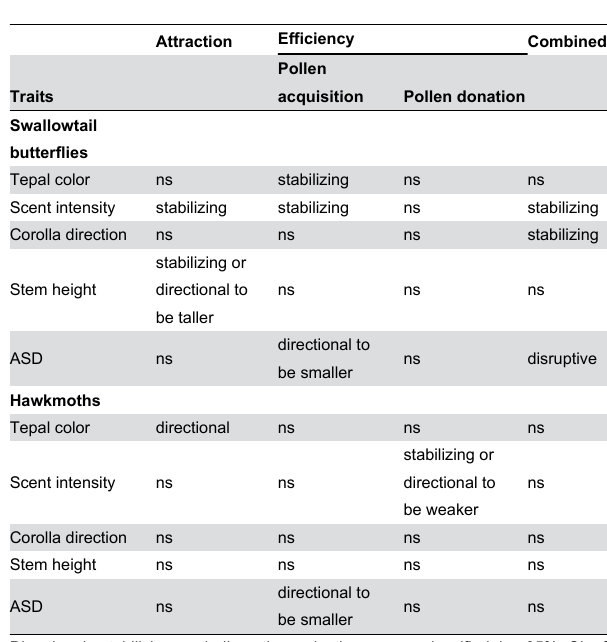
Table 2. The summarizing results of the hierarchical